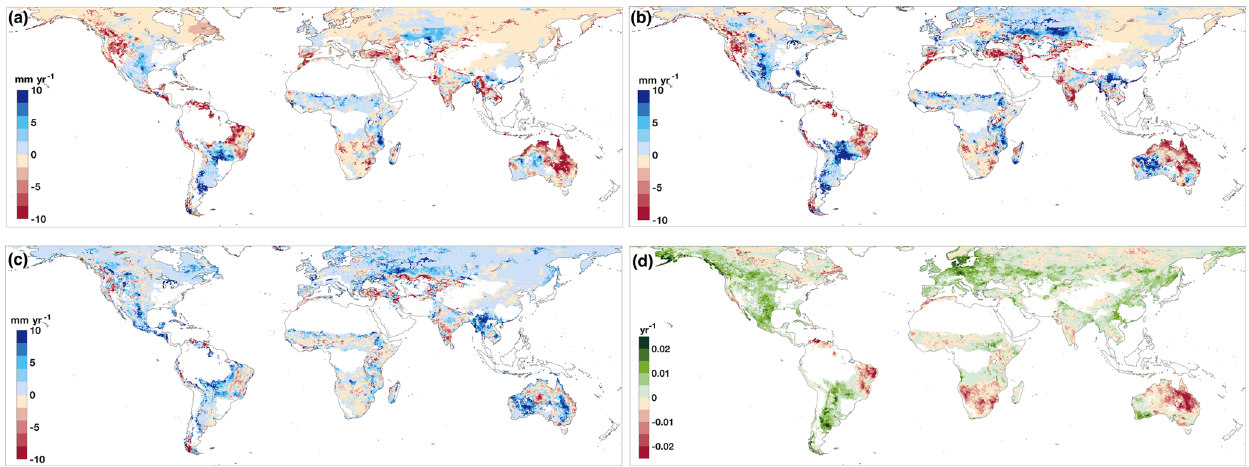
Figure 8. Change in soil water availability and vegetation greenness from 2010 to 2016: linear trends of accessible water storage anomalies estimated from (a) model open-loop and (b) joint assimilation; (c) difference in trends between joint assimilation and model open-loop; (d) linear trends of NDVI